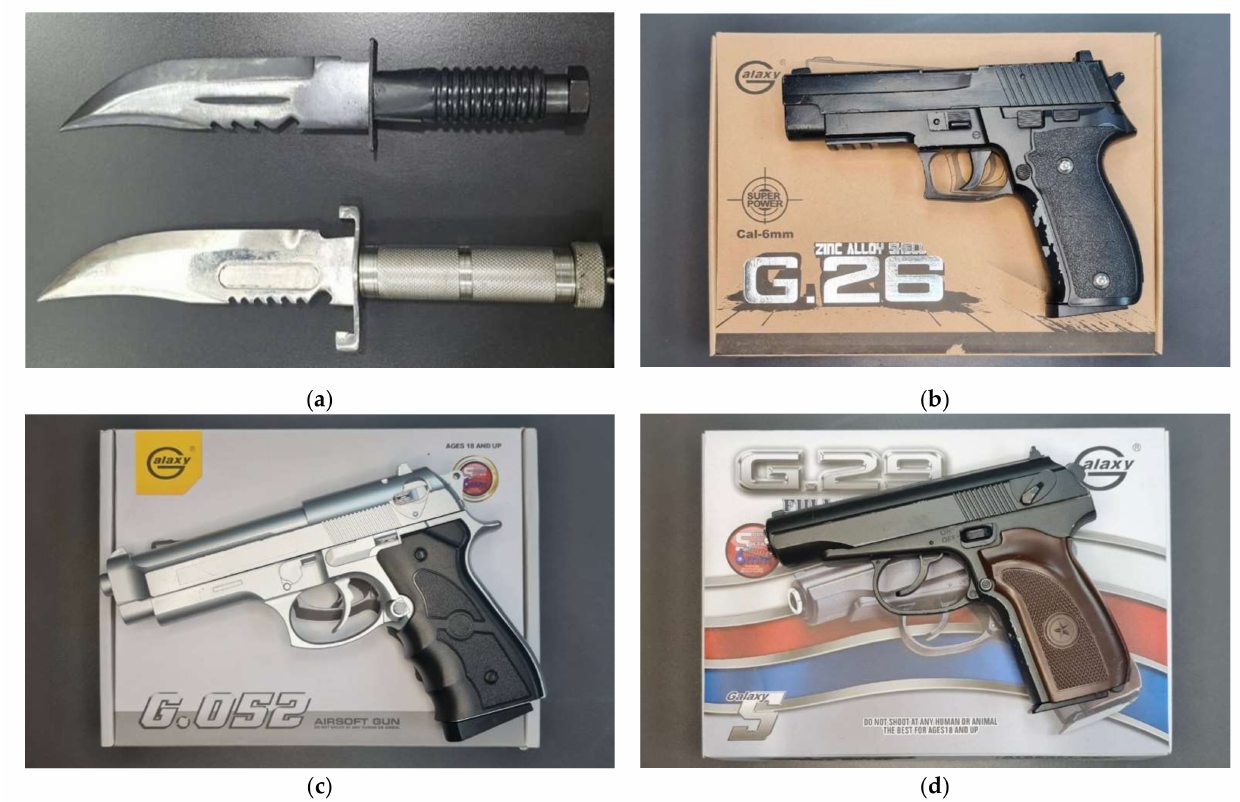
Figure 5. Example of weapons used in the data collection process: ( a ) combat knives, ( b ) BB gun airsoft Galaxy G.26 (Sig 226), ( c ) BB gun airsoft Galaxy G.052 (M92), ( d ) BB gun airsoft Galaxy G29